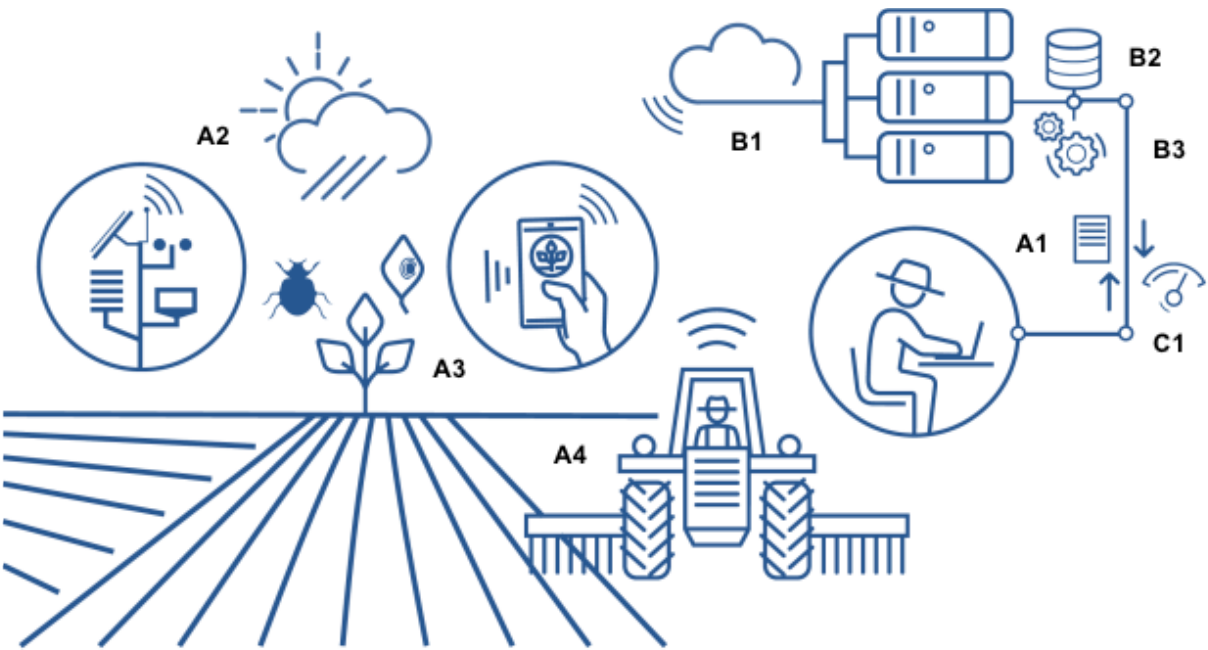
Figure 7. Scheme of a modern decision support system (DSS) for plant disease management. Information about crop- specific characteristics (A1), environmental conditions (A2), crop and plant status (A3), and agricultural operations (A4) flows asynchronously from the crop to a remote server (B1), and is stored in databases (B2). This information is then used as input for running mathematical models and decision algorithms (B3), which generate decision supports and alerts that help each grower decide whether, when and how to apply a